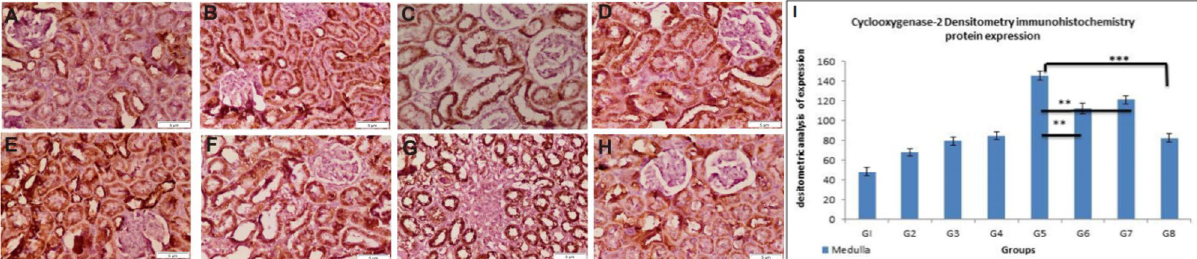
Figure 7. The effect of different treatments on COX-2 immunoreactivity and densitometry in CDDP-induced nephrotoxicity in all the studied groups. ( A – H ) COX-2 immunoreactivity evaluations in the kidney of rats. The control group ( A ), the GA group ( B ), the CMCS group ( C ), and the GA@CMCS group ( D ) showed a pale stain in the proximal tubular cells and a pale stain in the distal convoluted tubules and glomeruli. The